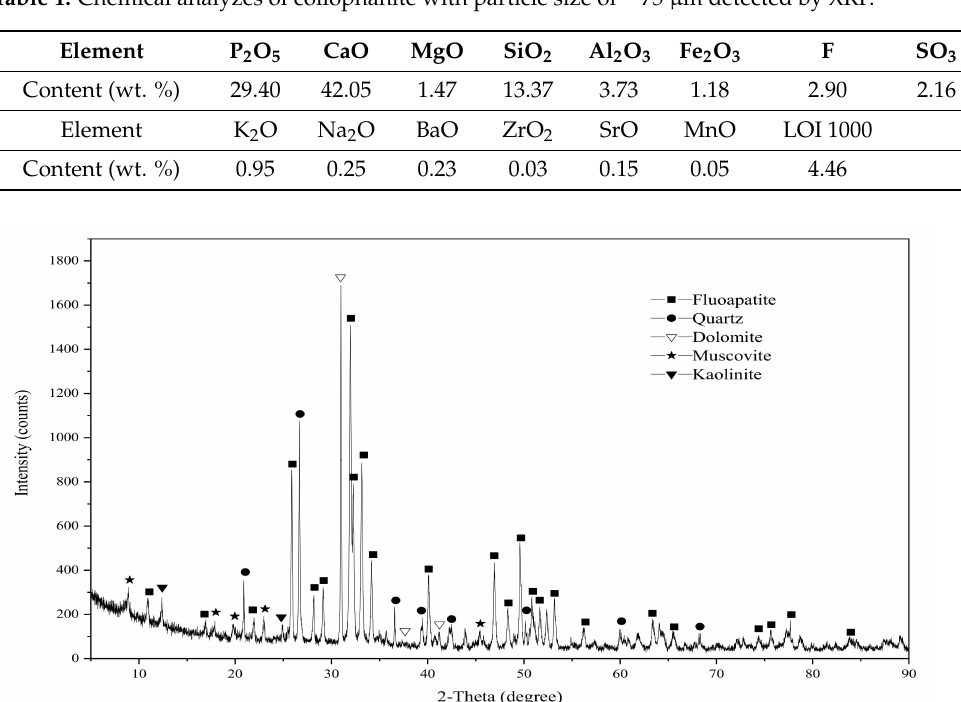
Table 1. Chemical analyzes of collophanite with particle size of − 75 µ m detected by XRF.